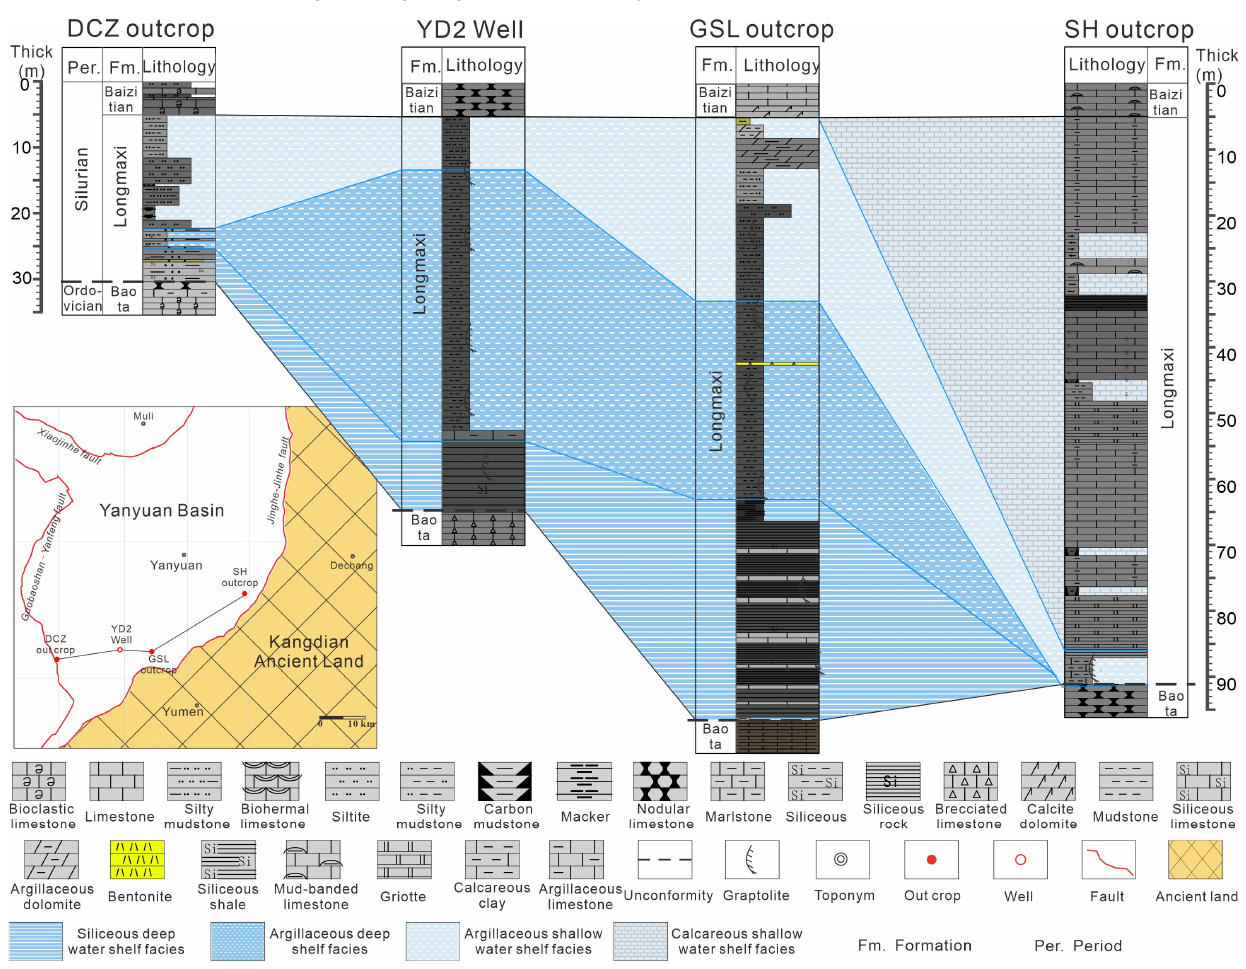
Figure 1. Diagram of depositional facies of the Longmaxi Fm of the Middle and Upper Yangtze region ( a ); geological sketch of Yanyuan Basin ( b ).